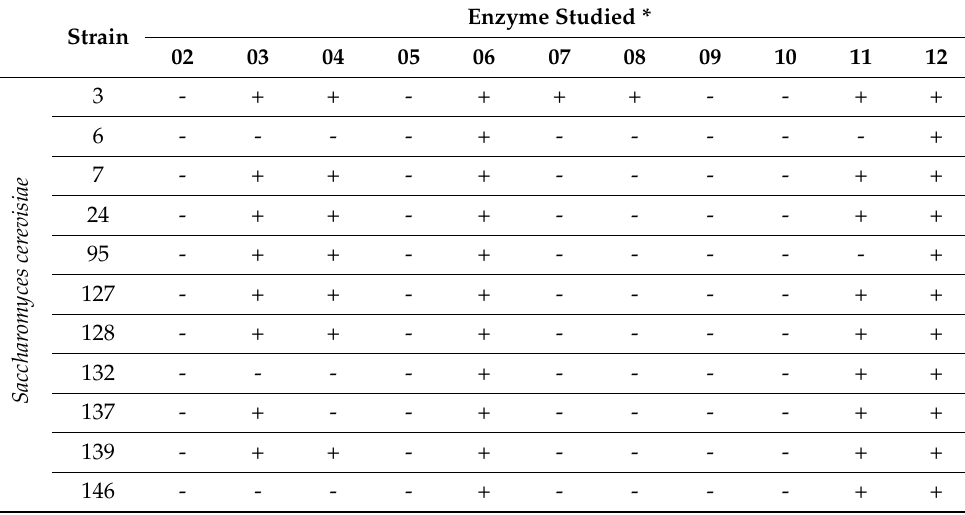
Table 3. Qualitative analysis of the enzymatic activity shown by the yeasts.